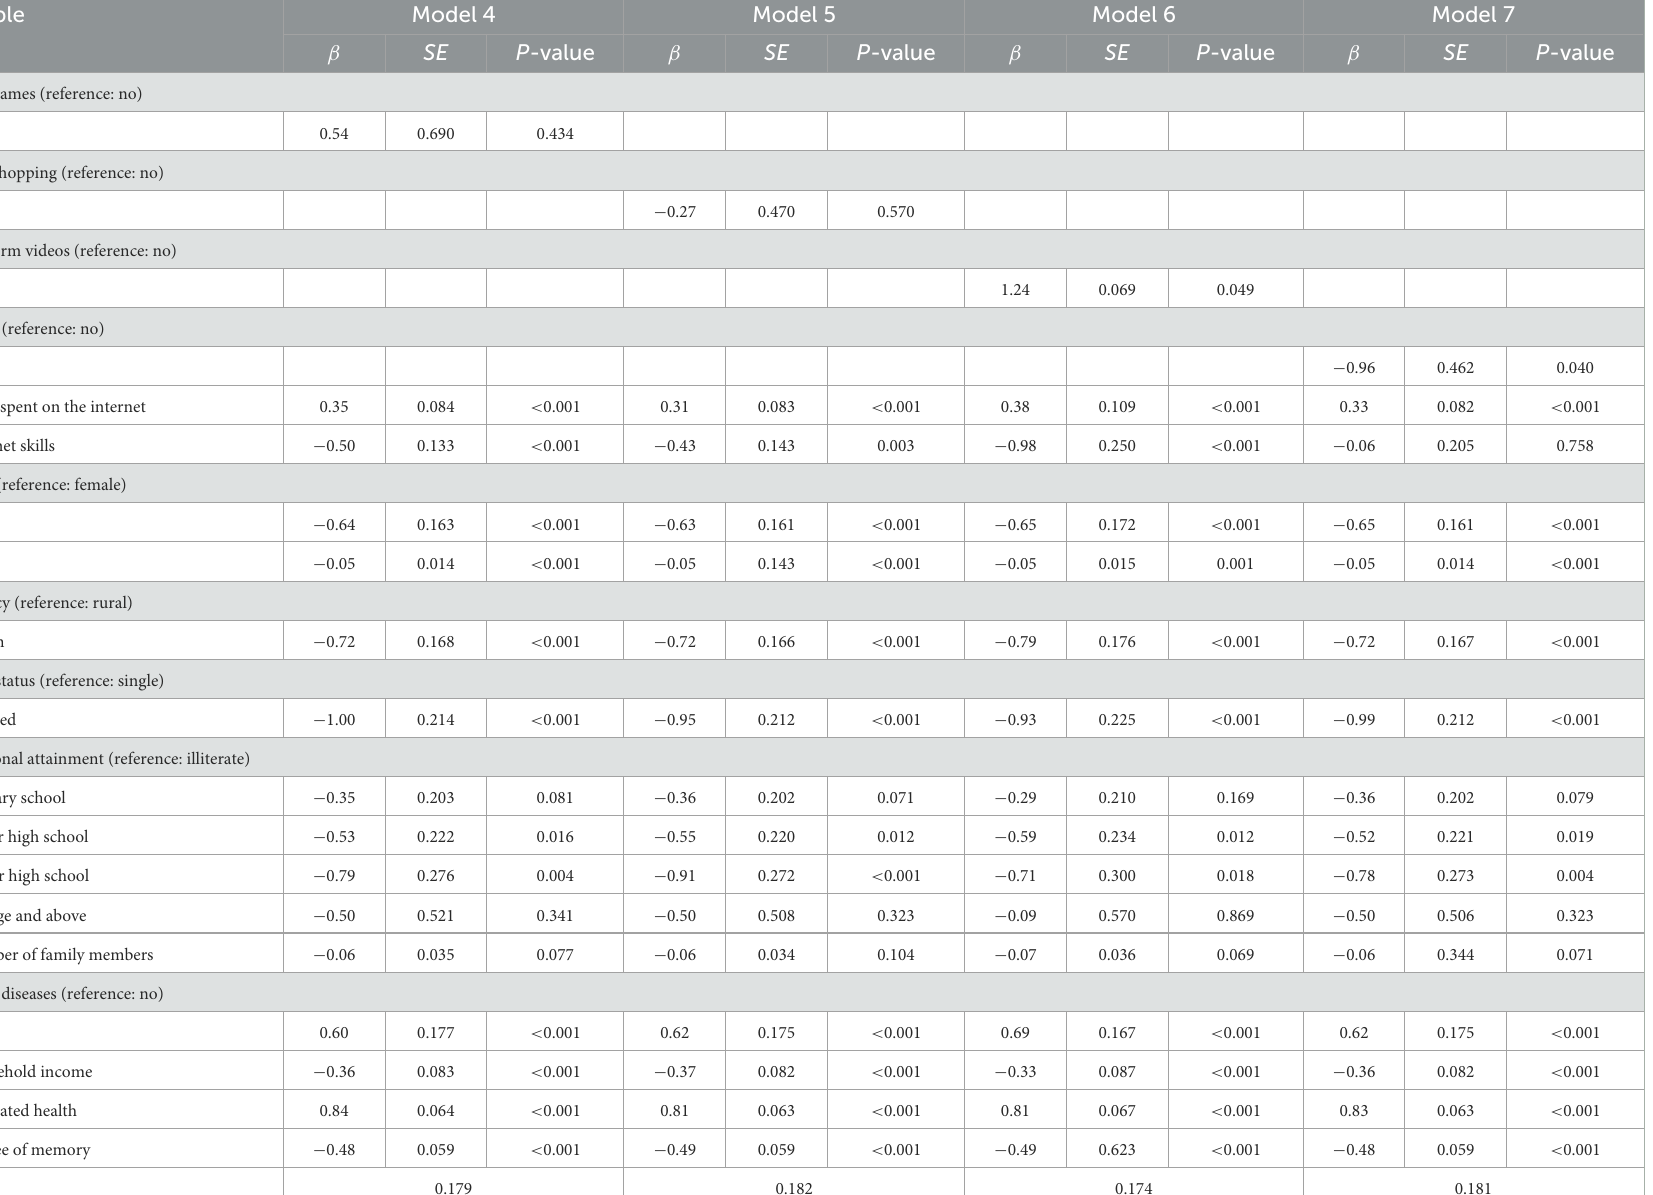
TABLE 4 Effects of types of online activities on depressive symptoms in older adults.